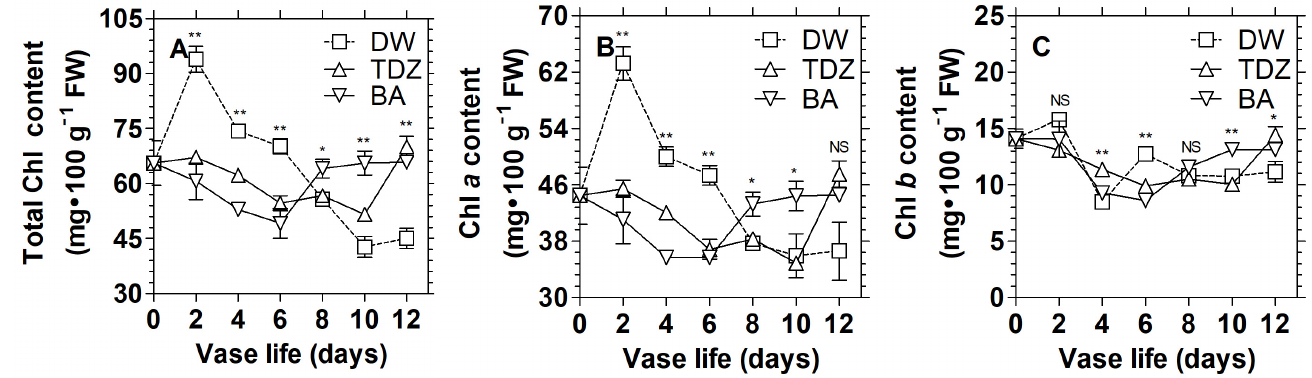
Figure 2. Effect of CKs on the contents of total Chl ( A ), Chl a ( B ) and Chl b ( C ) in D. solida leaves. Leaves were pulsed with distilled water (DW; control), 10 µ M TDZ, 100 ppm BA for 24 h, then transferred to distilled water in a controlled environment room for the vase period. Asterisks above the curves at each time point represent significant differences between treatments according to Duncan’s multiple range test (DMRT); p < 0.01 (**) and p < 0.05 (*), NS not